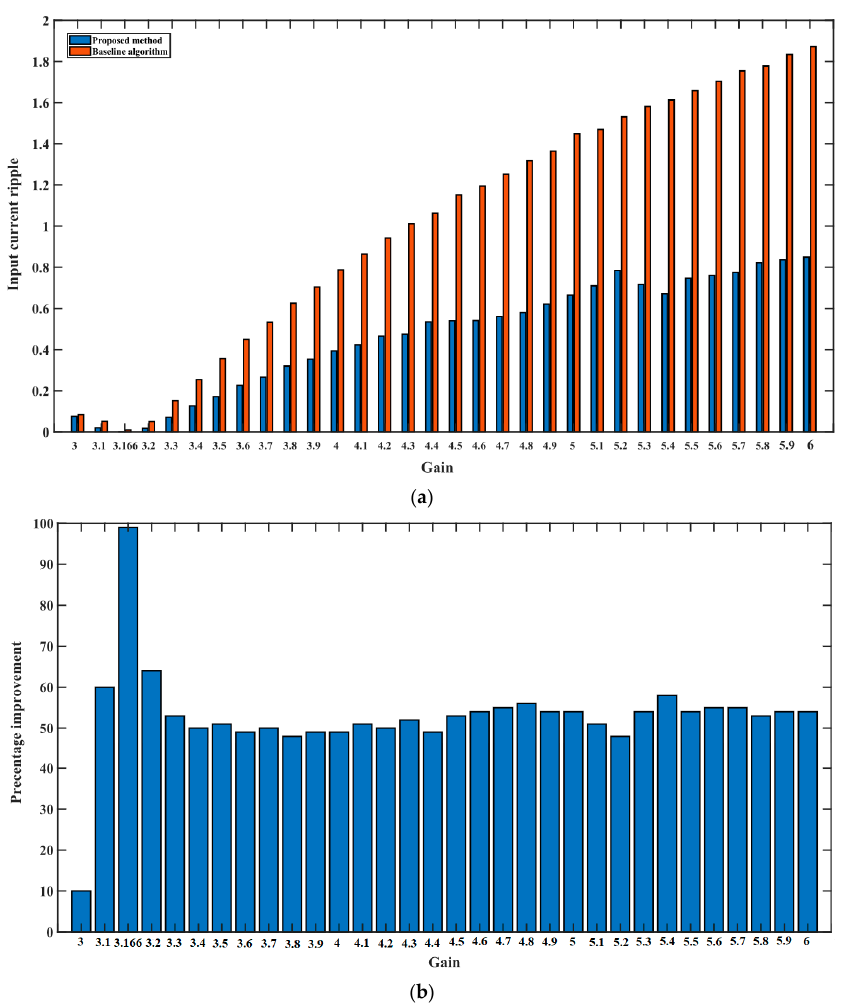
Figure 3. ( a ) Comparison between proposed method and baseline algorithm based on input-current ripple, ( b ) Percentage improvement of proposed method compared with baseline algorithm.